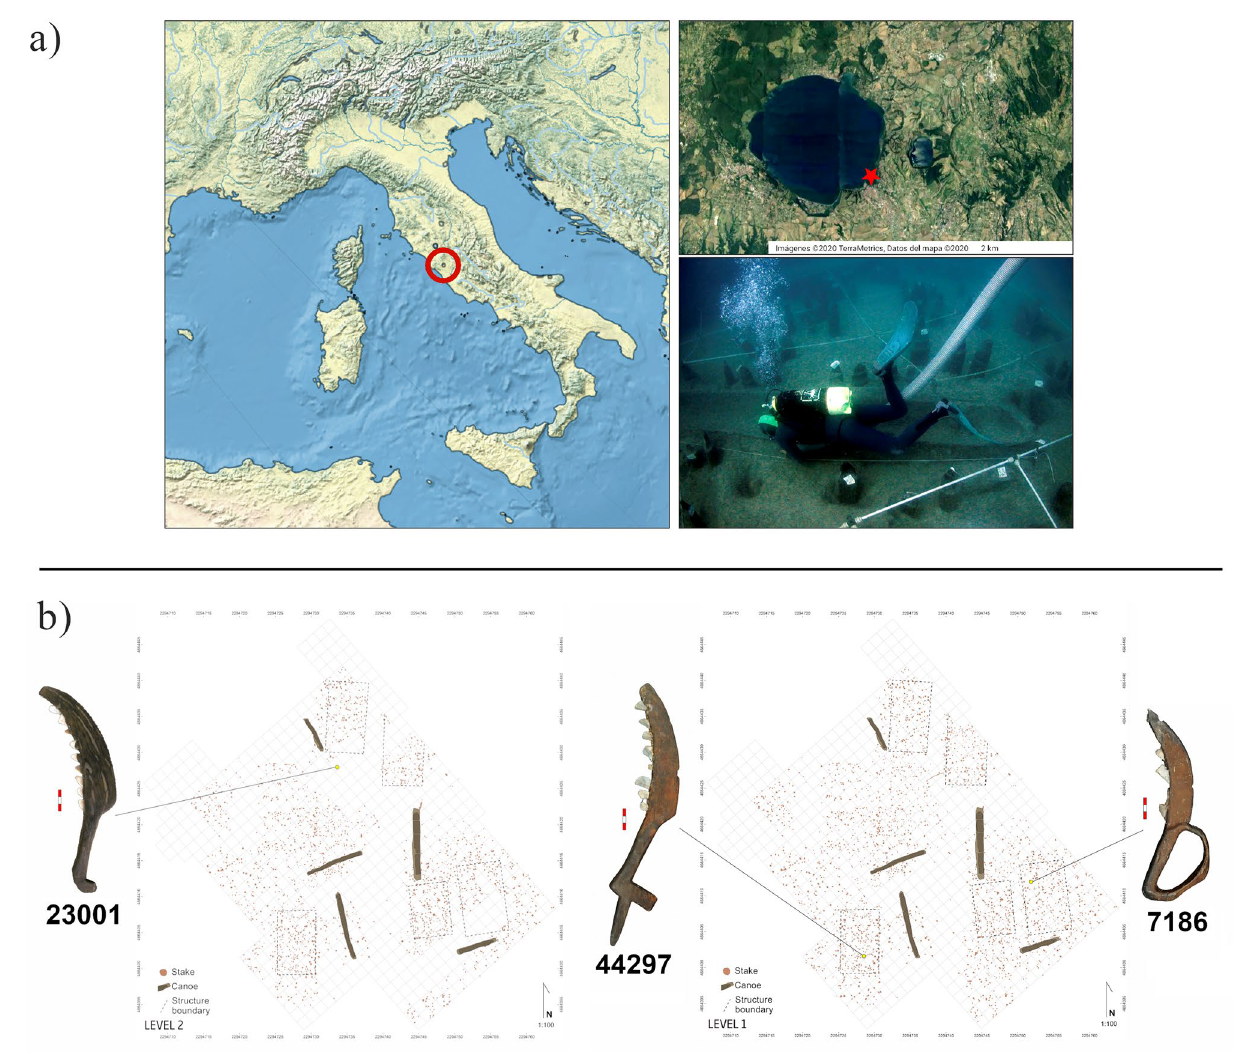
Figure 1. ( a ) Geographical position of La Marmotta. Photograph of the subaquatic excavation. Photo from Museo delle Civiltà (MuCiv); ( b ) position of the sickles within the two excavated layers (Layer I and II).